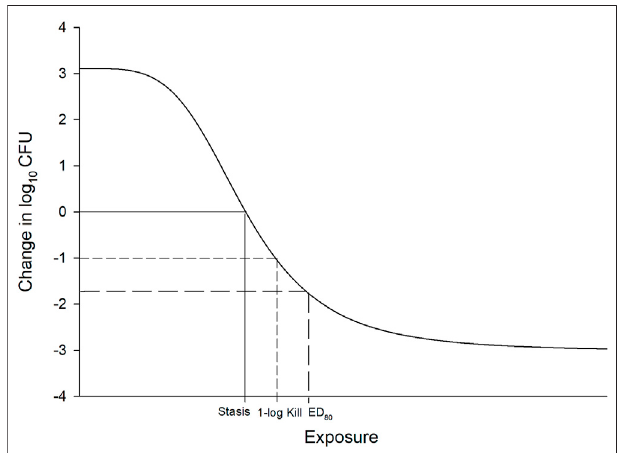
FIGURE 1 | Example of sigmoidal Emax model used to de fi ne exposure response relationship in pre-clinical and clinical studies. The x -axis is typically drug exposure (e.g., dose, concentration, T > MIC) and the y -axis is effect (i.e., change in log10 CFU from baseline). Stasis, 1 log 10 CFU reduction, and ED80 requirements are